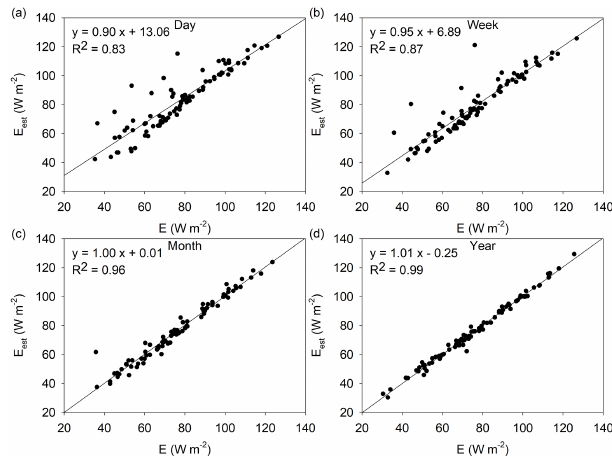
Figure 3. As in Fig. 1 except for the PGC function (Eq. 5).